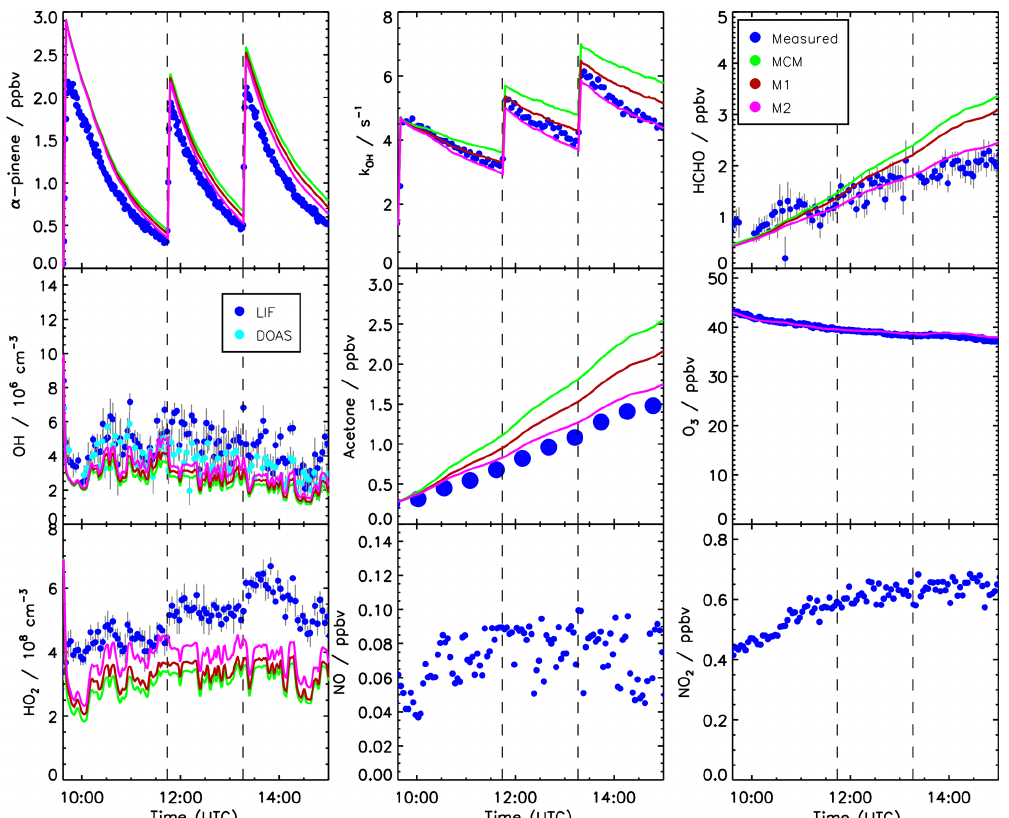
Figure 5. Time series of measured and modeled concentrations of radicals and inorganic and organic compounds during the α -pinene photooxidation at low NO (experiment on 30 August